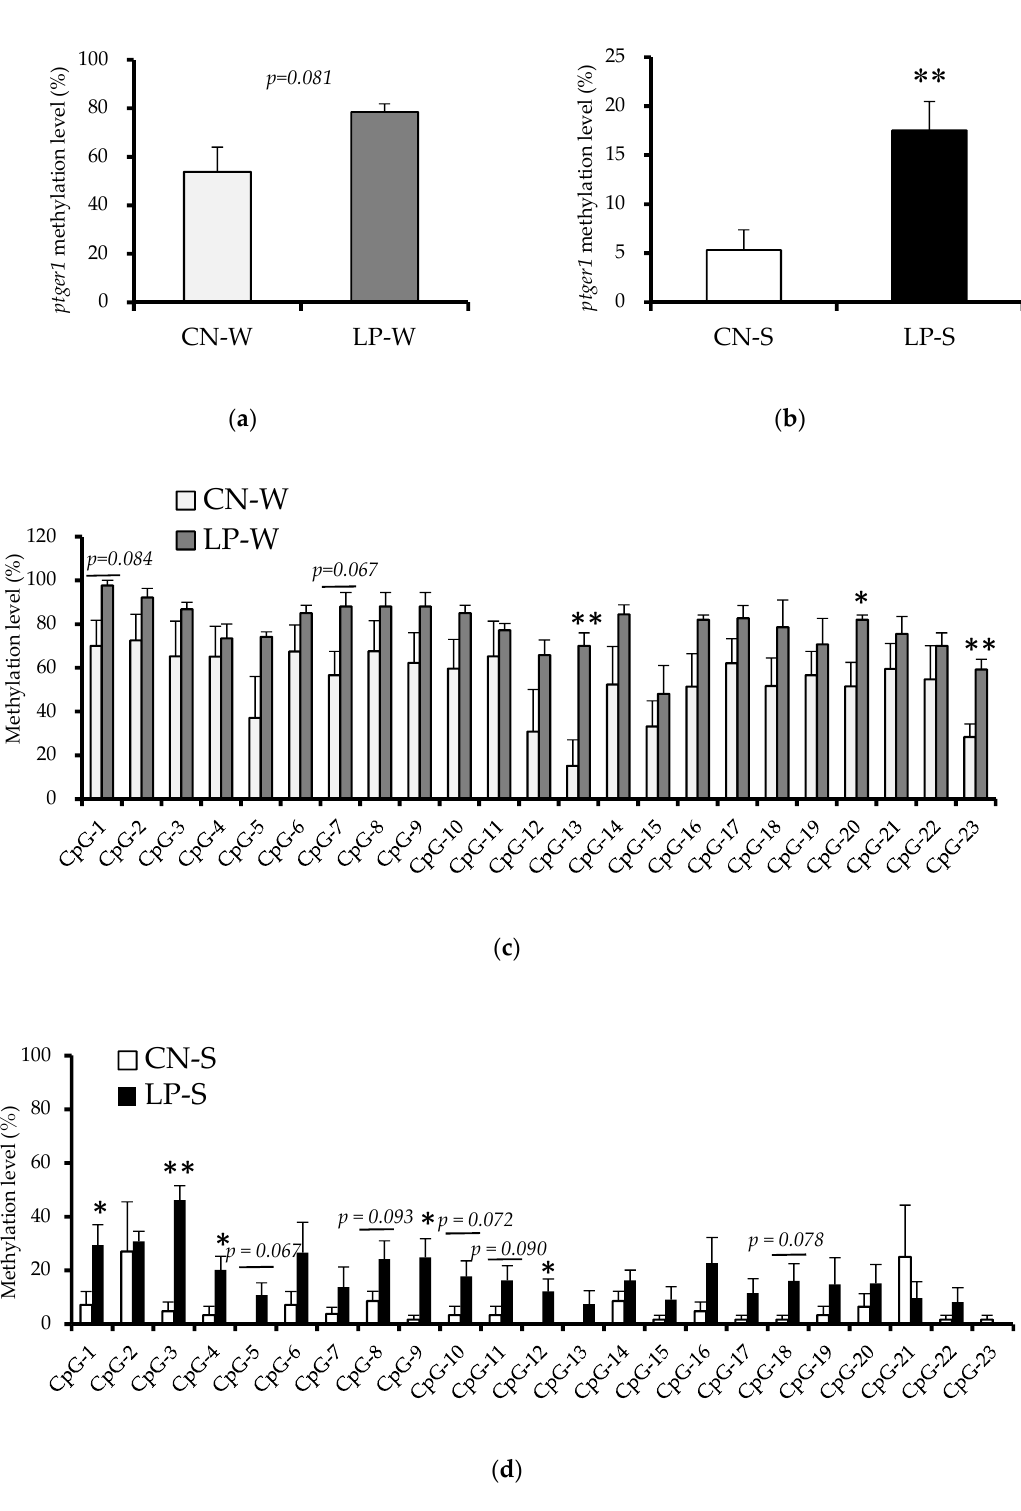
Figure 3. DNA methylation levels in the transcribed region of the ptger1 gene in offspring kidney samples. ( a ) The ptger1 total methylation level (Animal Experiment 1). ( b ) The ptger1 total methylation level (Animal Experiment 2). ( c ) Methylation levels at 23 ptger1 CpG sites (Animal Experiment 1). ( d ) Methylation levels at 23 ptger1 CpG sites (Animal experiment 2). Values are expressed as the mean ± standard error. ** p < 0.01, * p < 0.05 vs. the CN-W or CN-S offspring according to a Student’s t -test. Offspring were exposed to either an intrauterine environment of 20% (CN)-feeding mothers or that of 9% (LP)-Casein diet-feeding mothers, and provided with either water (W) or 1% saline drinking supply (S).CN-W, n = 3; LP-W, n = 3; CN-S, n = 5; LP-S, n = 6.